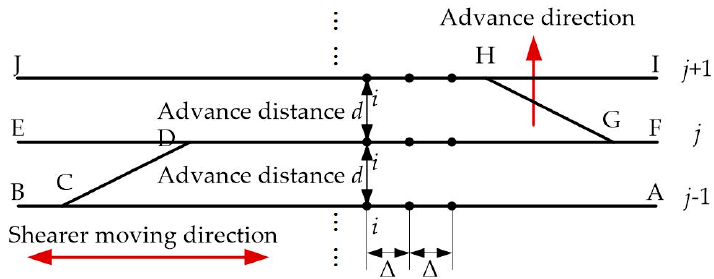
Figure 3. Closed path of shearer during the longwall mining. The initial positions of the optimal points are provided in the first cutting cycle.